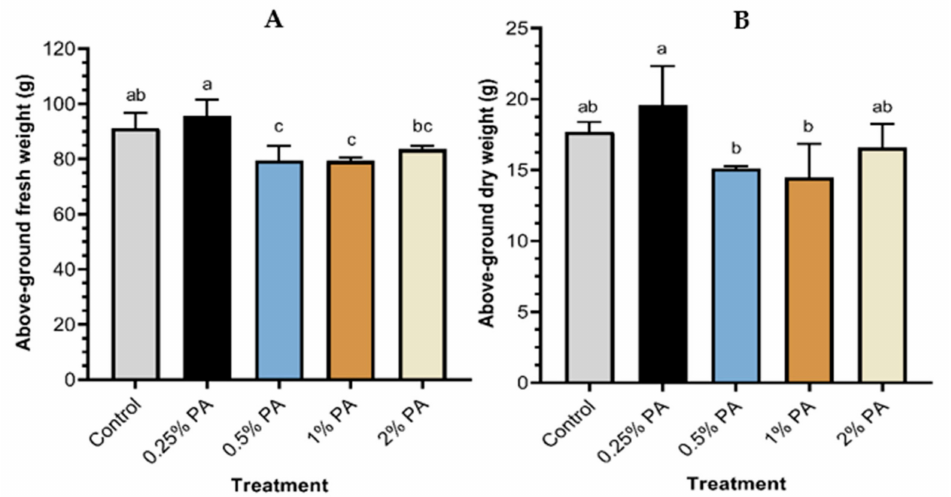
Figure 1. Pyroligneous acid effect on tomato plant above-ground biomass: ( A ) fresh weight and ( B ) dry weight. Values are the means of four replicates and different lowercase alphabetical letters indicate significant ( p < 0.05) difference according to Fisher’s least significant difference (LSD) post hoc test. Error bars show the standard